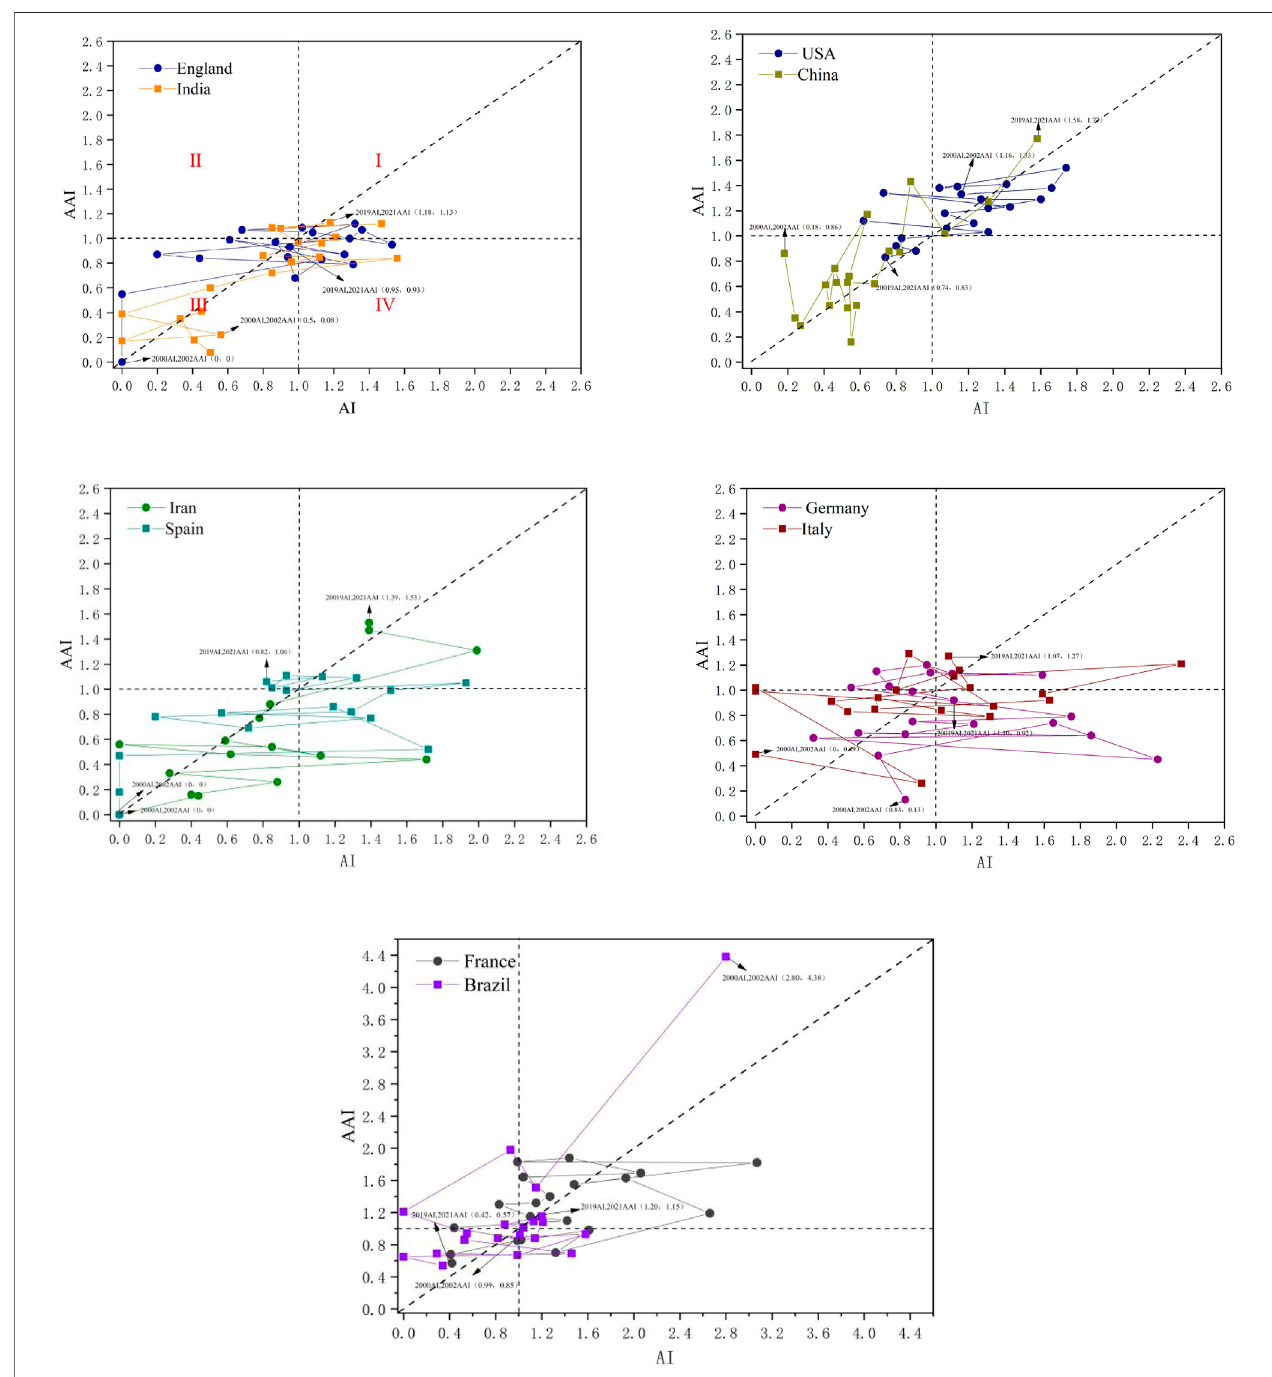
FIGURE 4 | Relational chart of AI and AAI from 2000 to 2021 for 10 countries/regions.